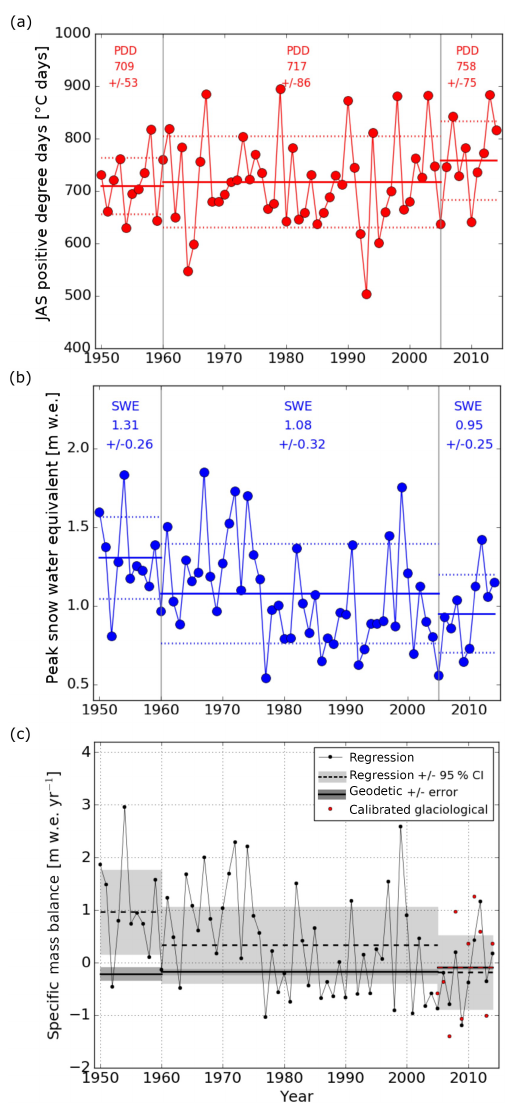
Figure 5. Annual climate data for 1950–2014 and comparison of regression and geodetic mass balance results. (a) Positive degree days (PDDs) calculated from the Kalispell Historical Climate Net- work summer (i.e., July, August, and September: JAS) temperature data, adjusted for elevation by the standard lapse rate. (b) Peak snow water equivalent (SWE), calculated from Mount Allen snow course data. Mean (solid line) and 1 standard deviation (dashed line) of PDD and SWE for each geodetic mass balance interval (1950– 1960, 1960–2005, 2005–2014) are plotted and reported in text with standard deviation. (c) Regression results for annual mass balance (black dots, thin black line) are shown, as are regression results for the average mass balance from 1950 to 1960, 1960 to 2005, and 2005 to 2014 (black dotted lines). Calibrated annual glaciological balances are shown (red dots), as is the average of this glaciolog- ical balance from 2005 to 2014 (red dotted line). Errors, set by confidence intervals on the linear regression, are also shown (light gray boxes). Geodetic mass balances for 1950–1960, 1960–2005, and 2005–2014 are plotted (horizontal black lines) with errors (dark gray